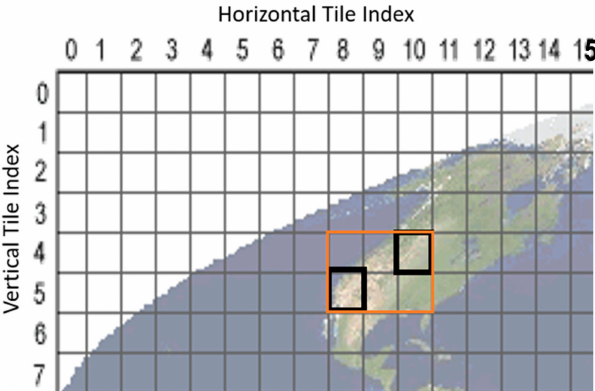
Figure 2. Map of tiles covering most of North America on the sinusoidal projection. Tiles h08v05 and h10v04, used for tile to tile comparisons are outlined in black, The SCE 1 km grid region used data from these six tiles h08v04, h09v04, h10v04, h08v05, h09v05, and h10v05 outlined in